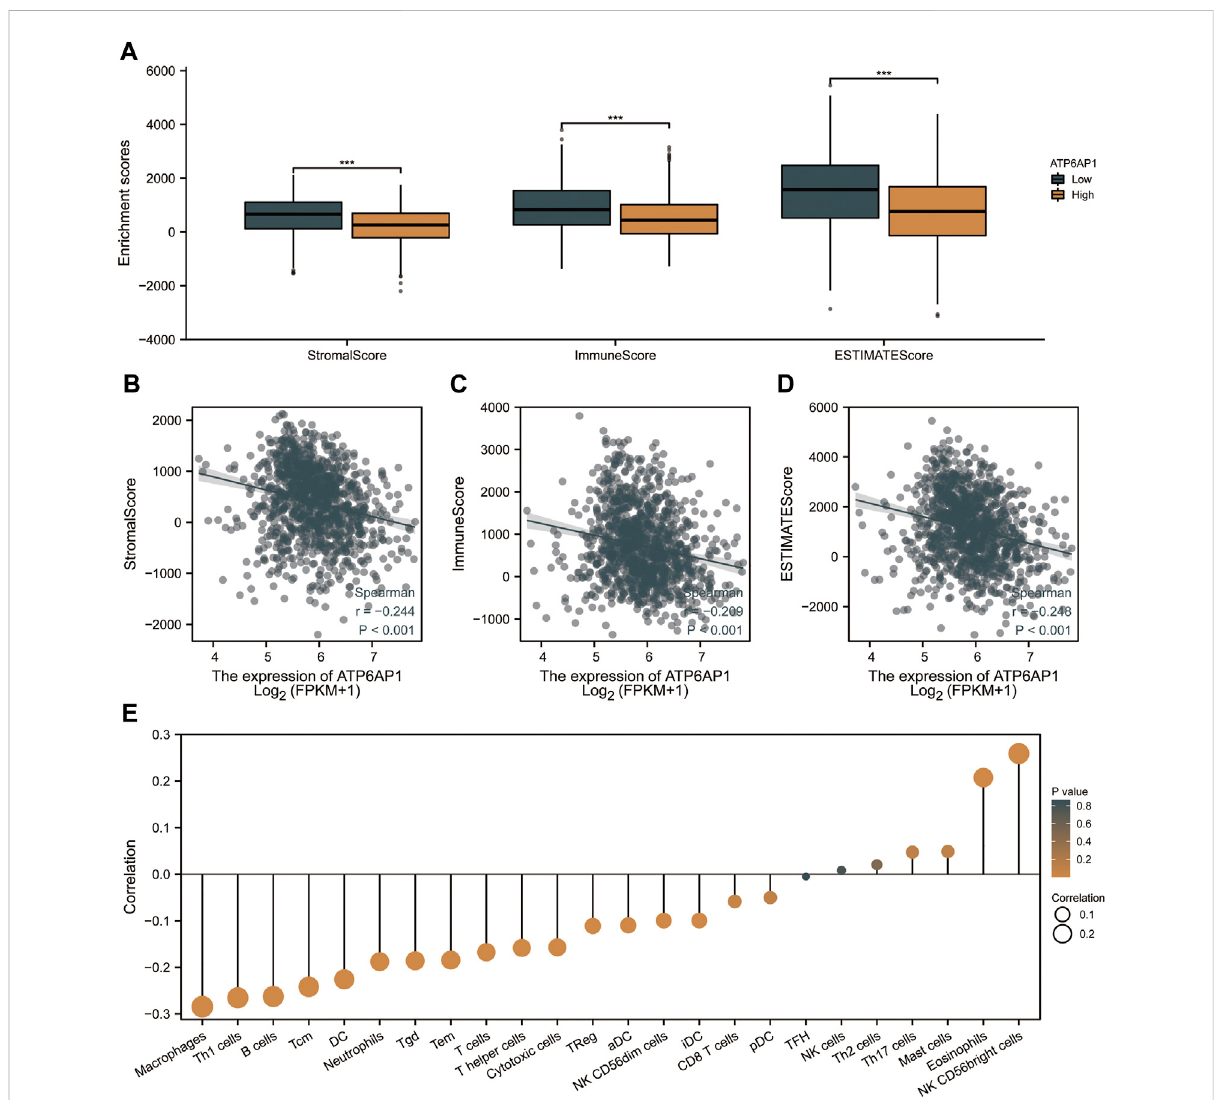
FIGURE 7 ATP6AP1 expression is associated with immune in fi ltration in TME. (A) Patients with high expression of ATP6AP1 had signi fi cantly lower StromalScore, Immune Score, and ESTIMATE Score ( p < 0.001) in comparison with patients with low expression of ATP6AP1. (B – D) StromalScore, ImmuneScore, and ESTIMATES Score were negatively linked with the expression of ATP6AP1 ( p < 0.001). (E) Lollipop plot illustrates the connection between therelativeabundanceof24 immune cells andATP6AP1 expression. ns,non-signi fi cant ( p ≥ 0.05); * p < 0.05;** p < 0.01; *** p <